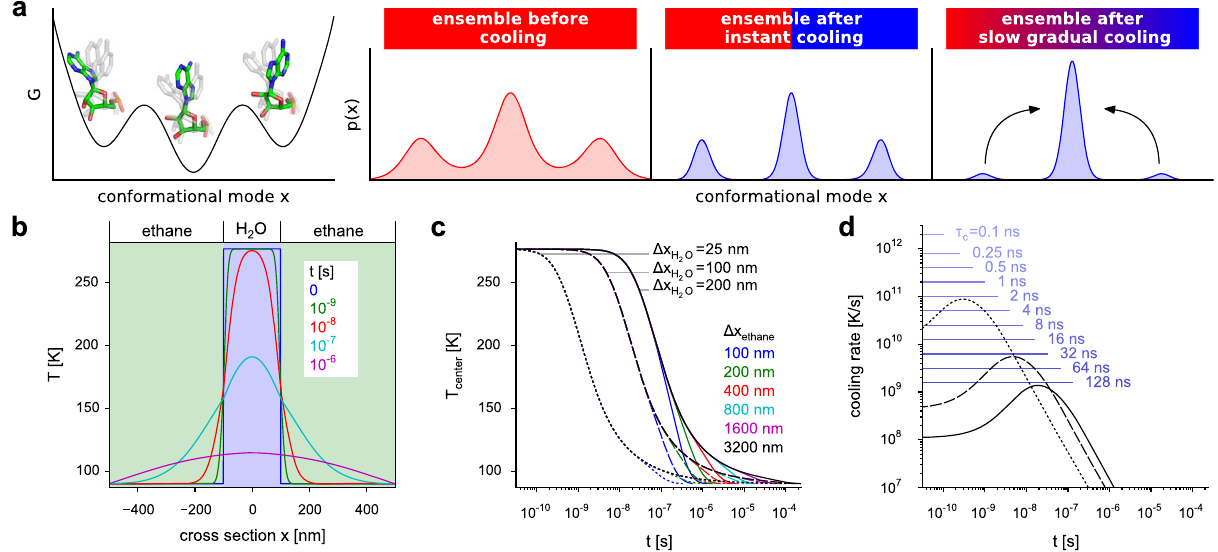
Fig. 1 Effect of cooling on structural ensembles and estimated temperature drop during plunge-freezing. a Schematic of a free-energy landscape along a conformational mode (left) and probability densities of structural ensembles (from left to right) before cooling, after instant cooling, and after slow cooling. b Temperature drop during plunge-freezing of a water layer embedded in ethane. Solution of the heat equation for a layer of water (thickness Δ x = 200 nm) surrounded by two layers of ethane (thickness Δ x = 400nm, each). The temperature pro fi le T is shown for different times t . ethane H 2 O Temperatures at the left and right borders are kept at 90 K. c The temperature T center at x = 0 nm is shown as function of time t for different thicknesses of water and ethane layers. d The cooling rate at x = 0 nm is shown as function of t for different water-layer thicknesses and for Δ x ethane = 3200 nm. Cooling rates for linear temperature decreases with different cooling time spans τ c are shown as blue